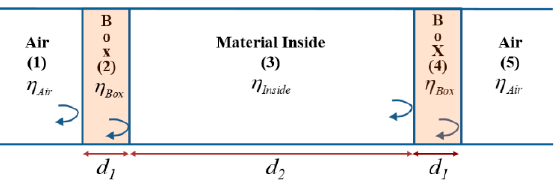
Figure 2. Five-layer model of the cardboard box. Curved arrows represent reflection.